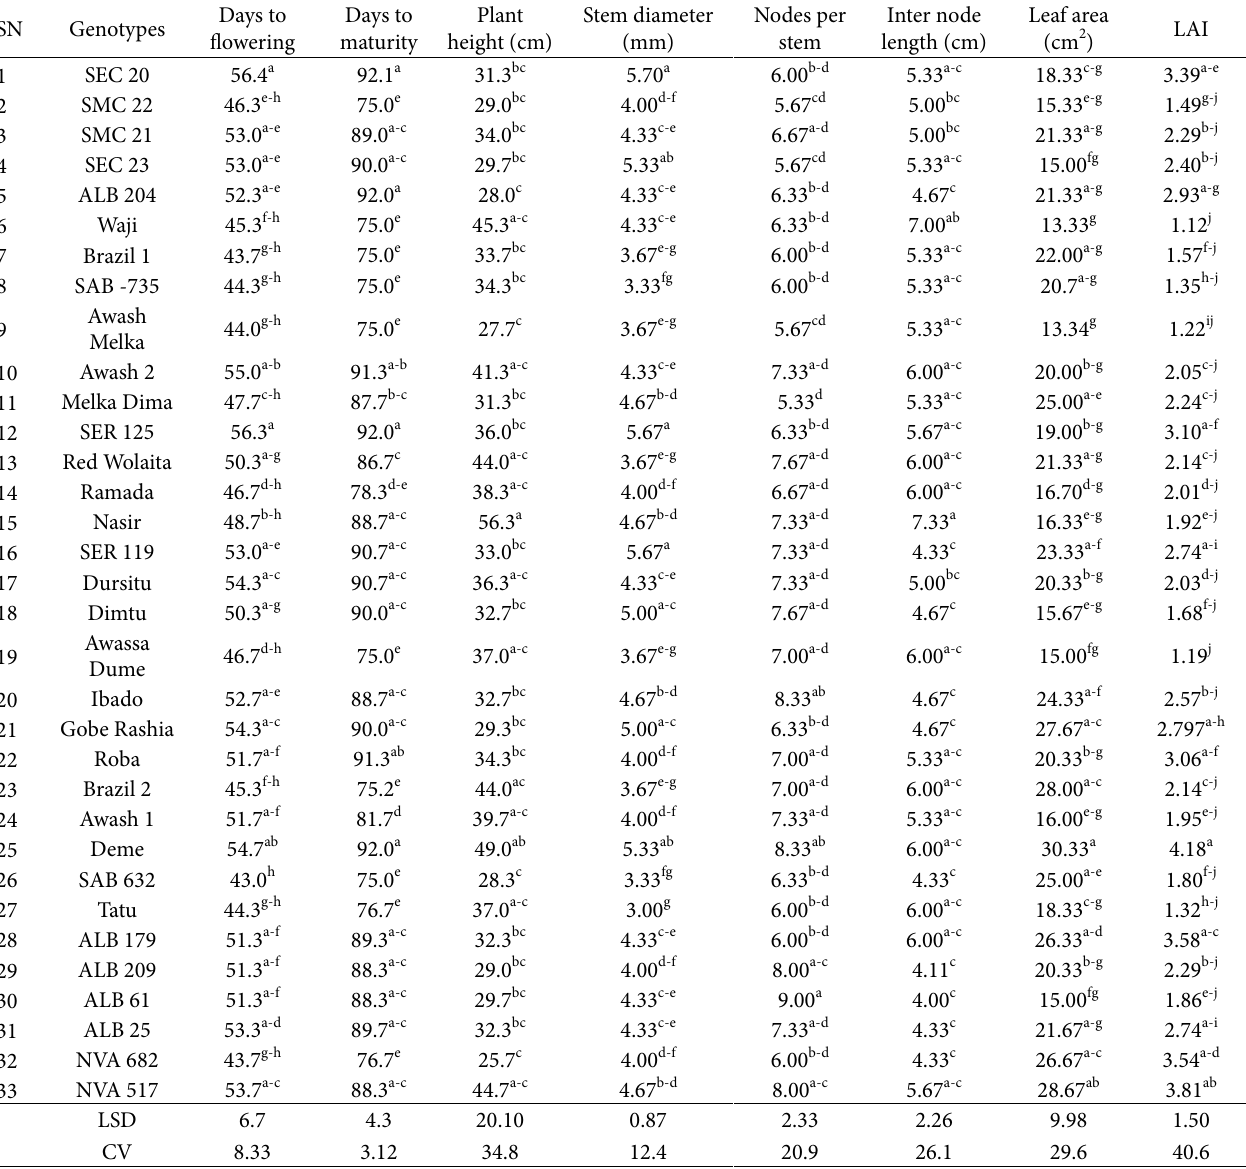
Table 1: Mean performance of genotypes of common bean for phenological and growth traits.